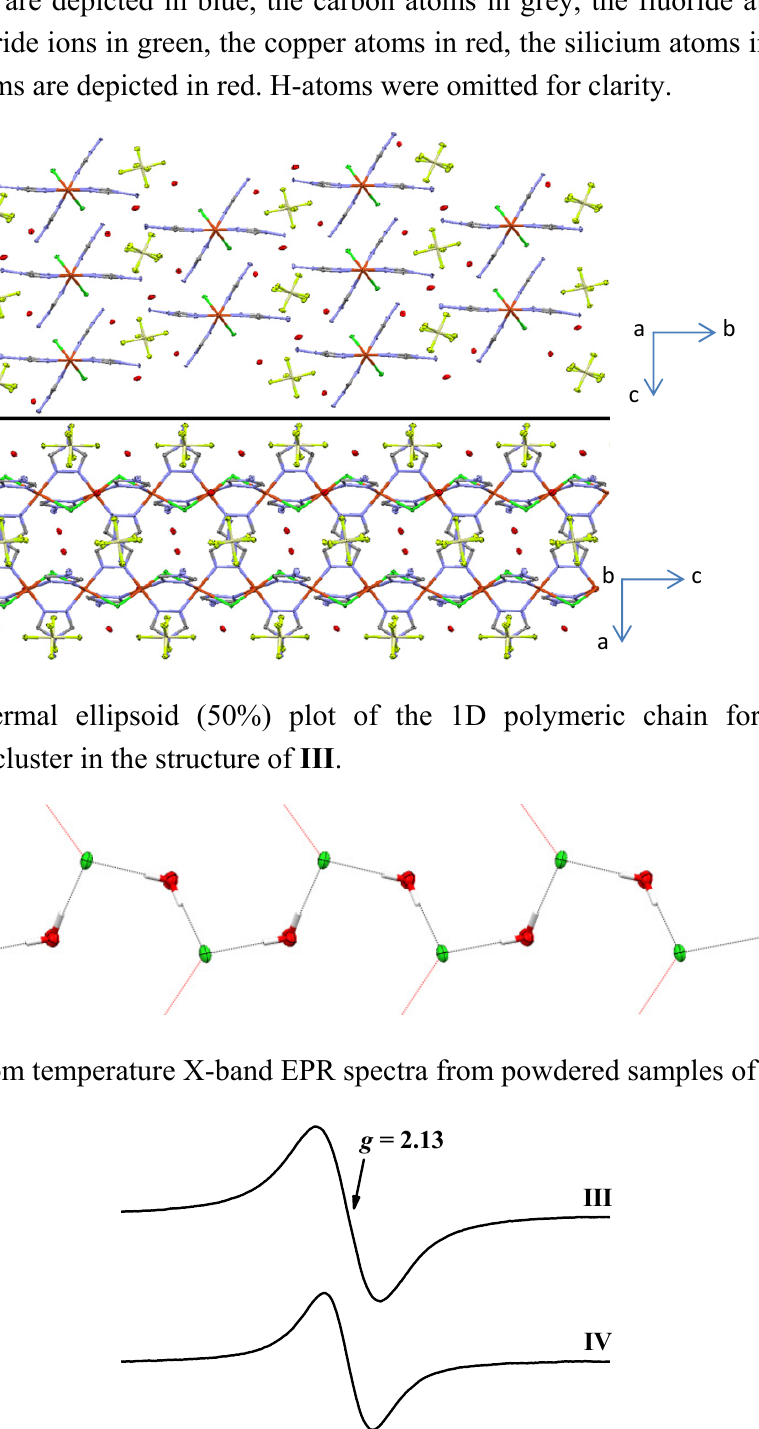
Magnetic susceptibility measurements were recorded for powdered samples of III and IV over the 5–300 K temperature range at an applied field of 0.1 T (Figure 8). At room temperature, the χ are 0.40 and 0.39 cm 3 mol − 1 K for III and IV , respectively, comparable with that expected for one Cu(II) ion ( S = 1/2). The temperature profiles of the magnetic susceptibility for both complexes